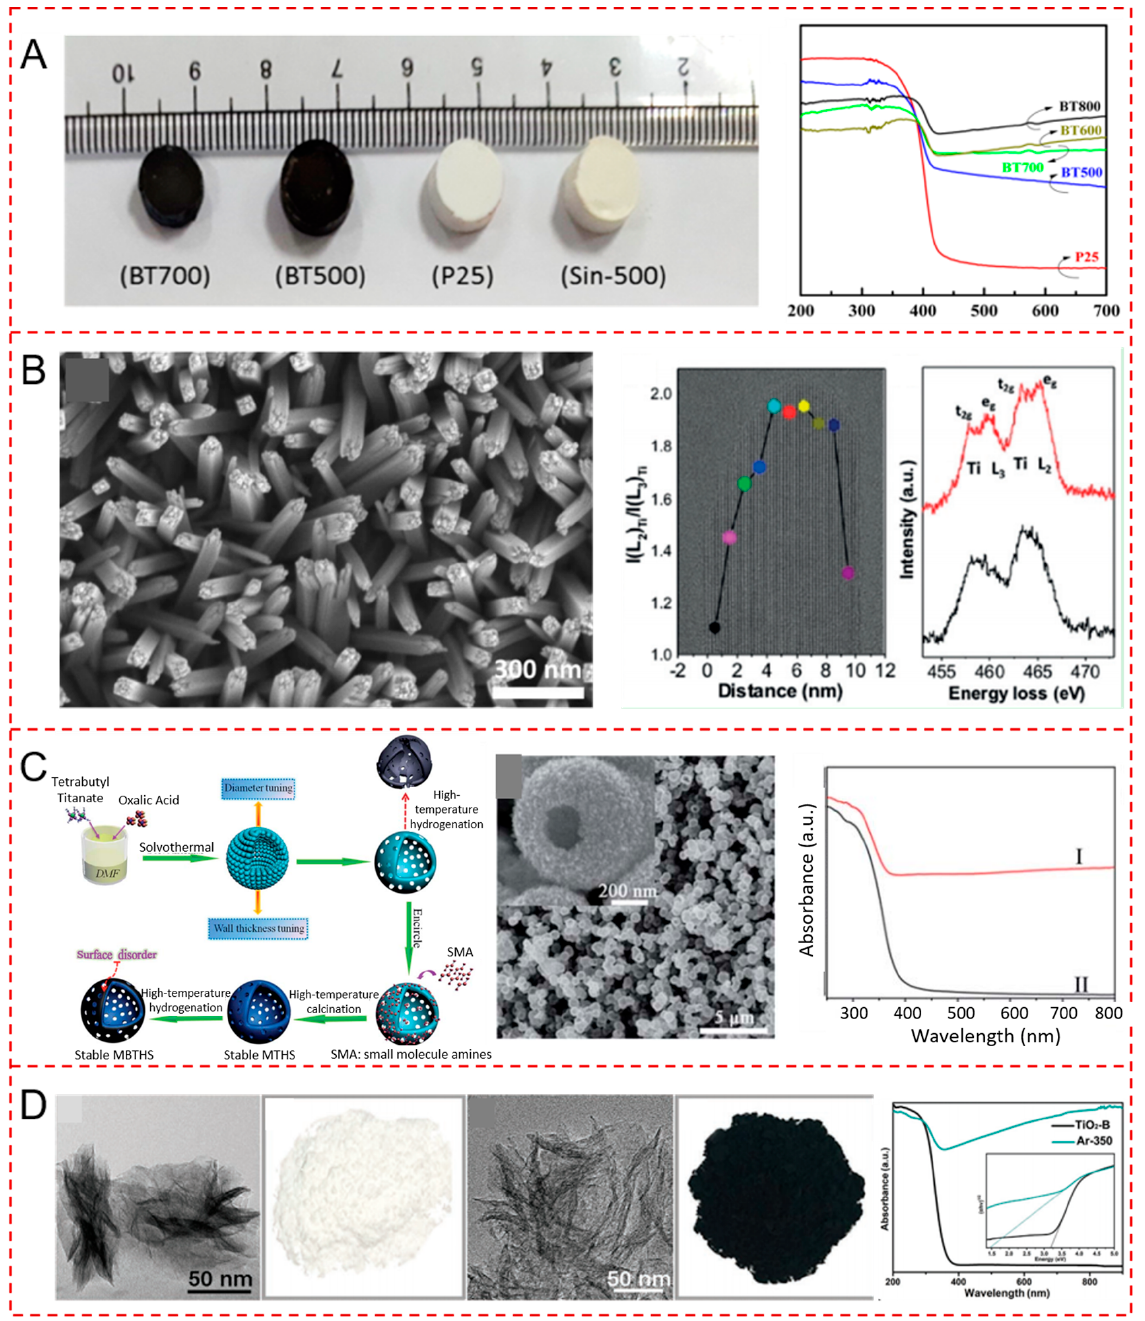
Figure 2. ( A ) Picture and UV-vis spectra of reduced P25 pellets at various temperatures. Reprinted with permission for ref. [63]. Copyright 2018, American Chemical Society. ( B ) SEM and TEM image and overlaid I(L 2 ) Ti /I(L 3 ) Ti values determined from the EELS Ti L 2,3 data at each position of R-HTNWs. Reprinted with permission for ref. [47]. Copyright 2019, Wiley-VCH. ( C ) Schematic illustration of the synthetic procedure, SEM image, for MBTHSs and UV-vis absorption properties (I: mesoporous black TiO 2 hollow spheres; II: mesoporous TiO 2 hollow spheres). Reprinted with permission for ref. [64]. Copyright 2016, The Royal Society of Chemistry. ( D ) TEM images, and optical photographs of (black) TiO 2 , and UV-vis spectra. Reprinted with permission for ref. [67] Copyright 2021, Wiley-VCH.